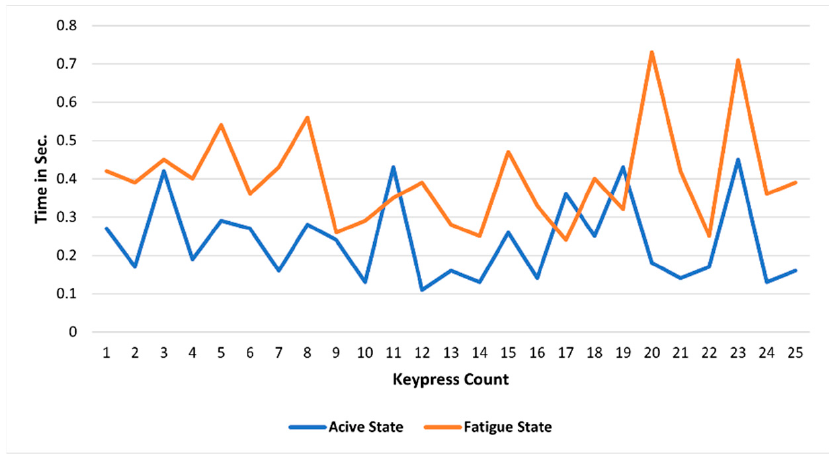
Figure 4. Active vs. fatigue keystroke pattern for the same word and same subject.